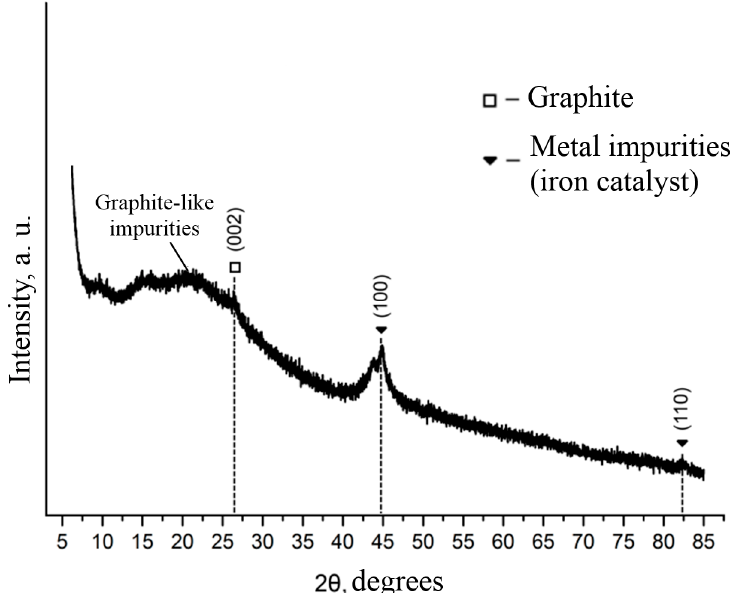
Figure 6. Diffraction pattern of the Tuball TM single ‐ walled carbon nanotubes.